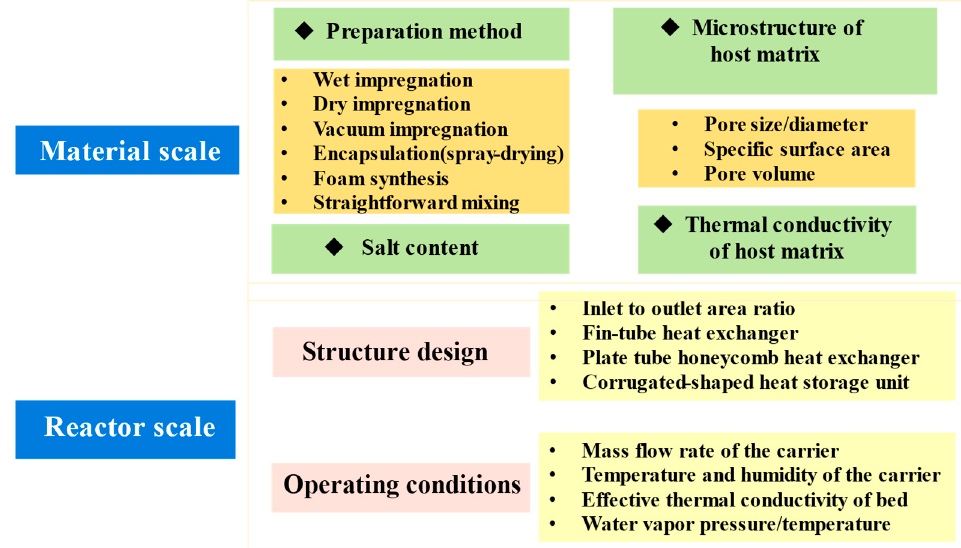
Figure 17. Diagram of the content in this section.